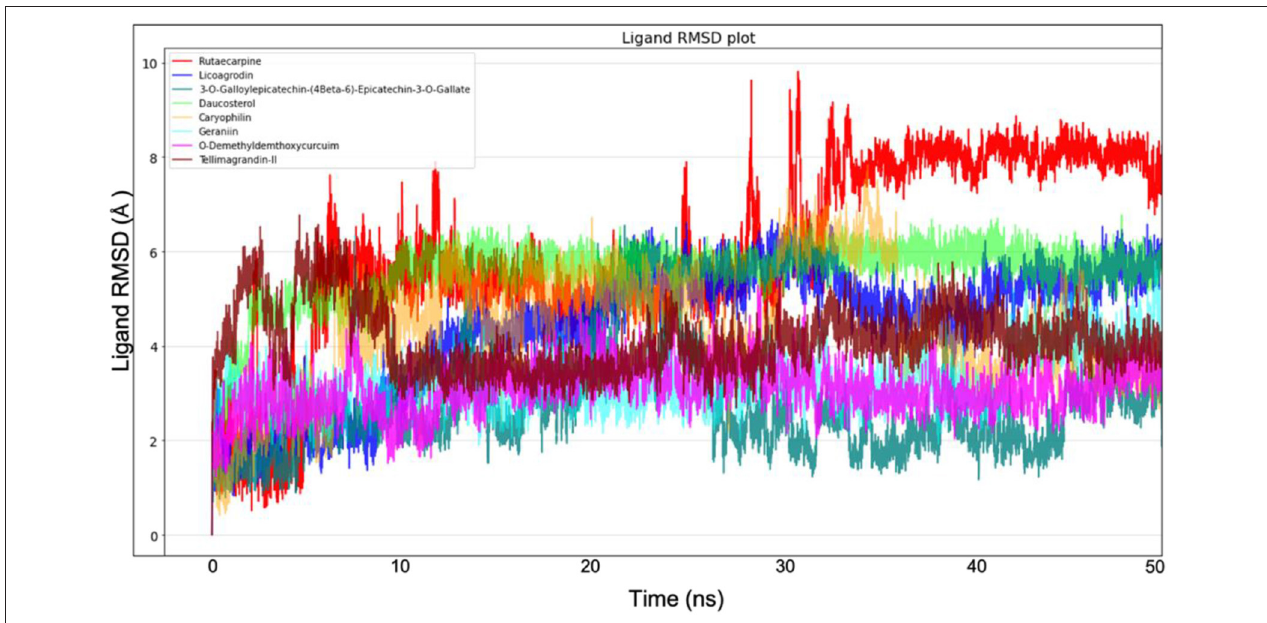
FIGURE 8 | Ligand RMSD plot from Molecular dynamics for all the 8 molecules.